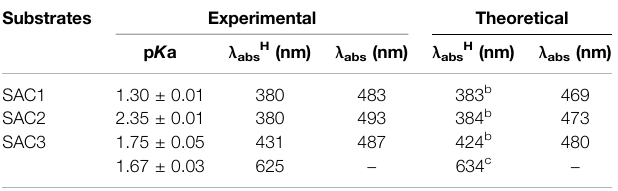
TABLE 1 | Experimental and theoretical p K a values and maximum absorption lengths of the neutral ( λ abs ) and protonated ( λ absH ) SACs. a Substrates Experimental